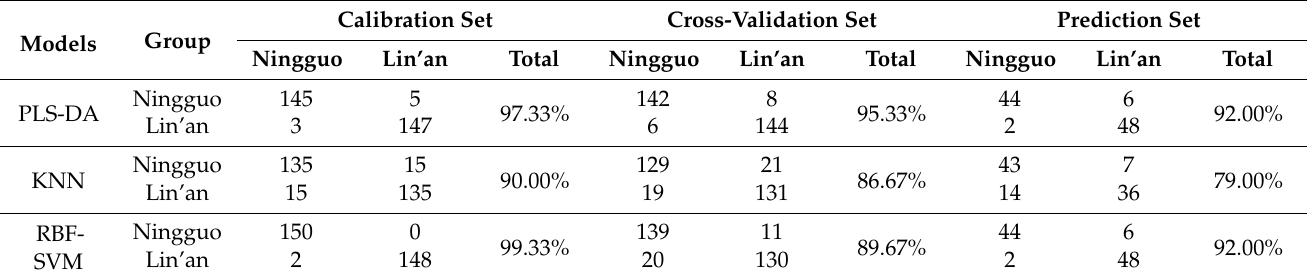
Table 2. Confusion matrices of the optimal PLS-DA, SVM and KNN models based on full spectra. Models